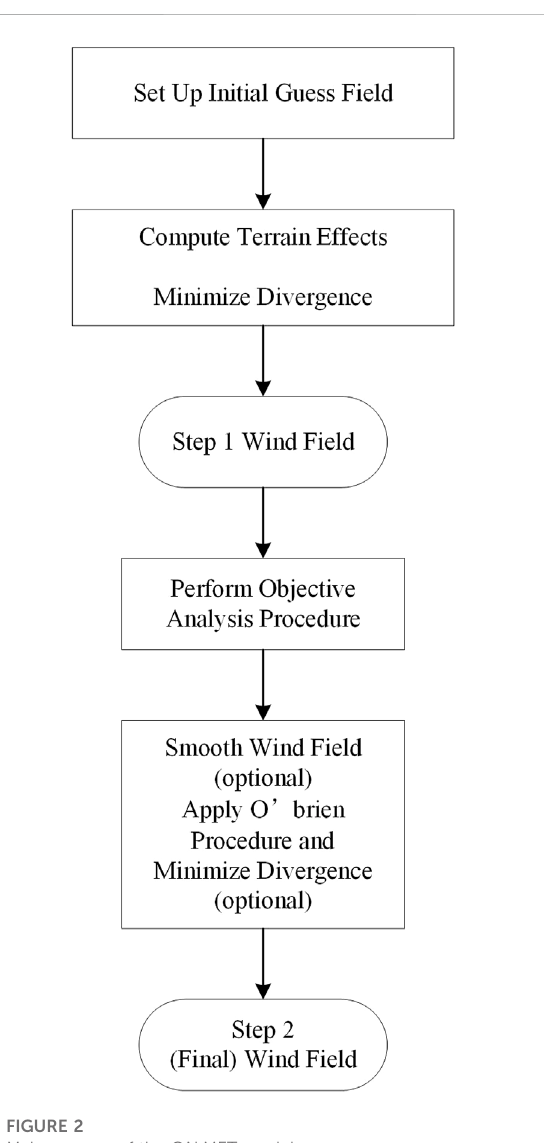
FIGURE 2 Main process of the CALMET